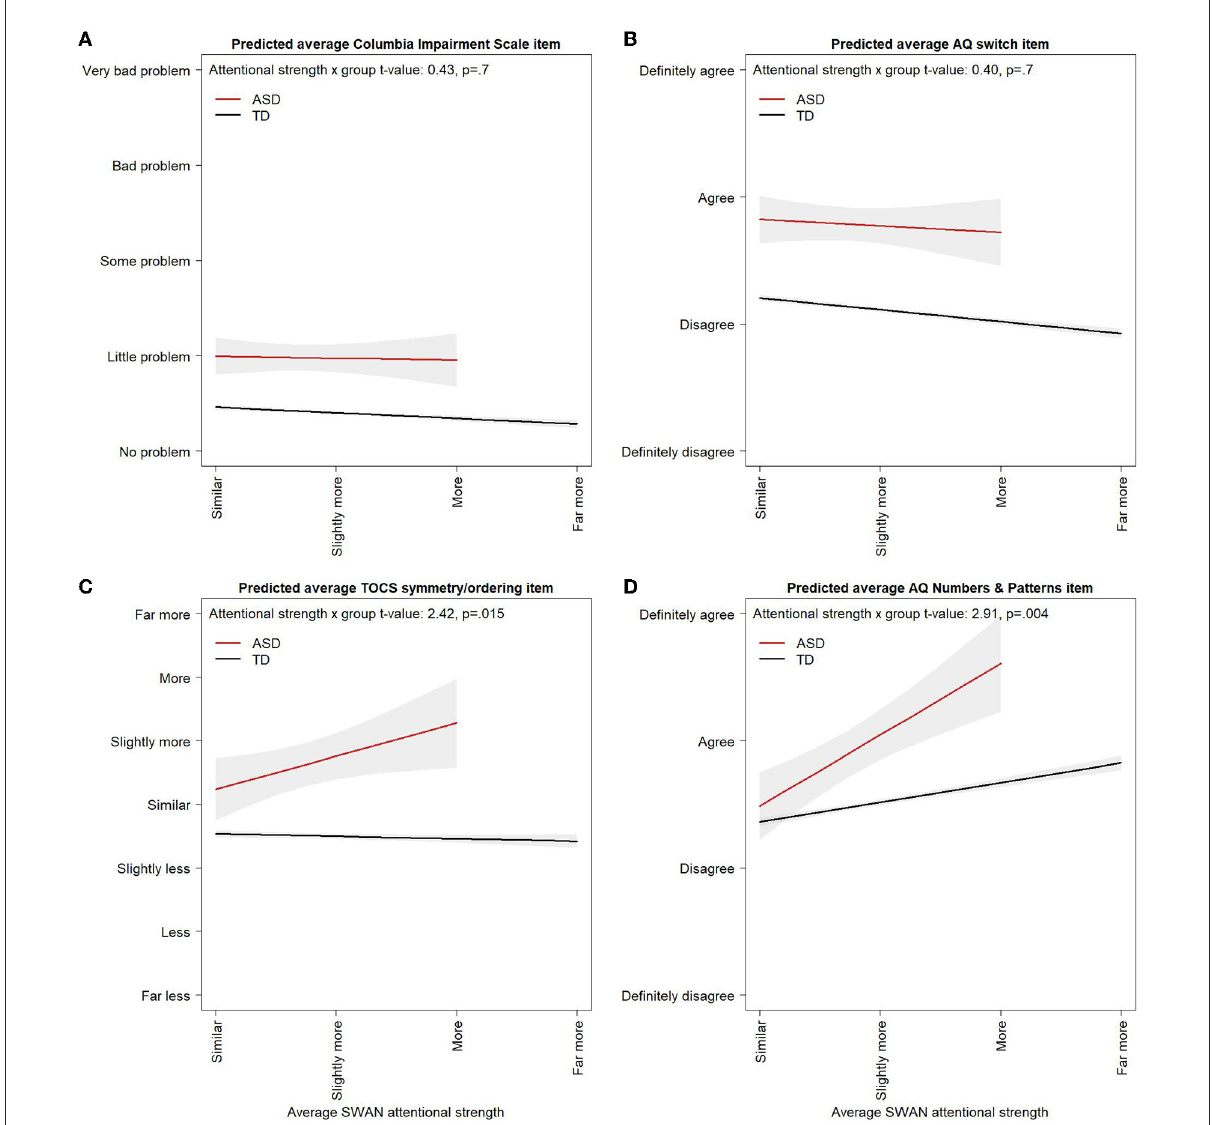
FIGURE3 Correlates of attentional strengths in ASD and controls. Multivariable linear regression model predicted values for (A) average AQ switching item, (B) average Columbia Impairment Scale item, (C) average TOCS symmetry/ordering item, and (D) average AQ-short-C Numbers and Patterns item across average attentional strength scores in the ASD and Control samples. Models control for age, gender, and attentional weakness scores. Multivariable linear regression model predicted values are shown for 11-year-old males with attentional weakness scores of 0. Varying the age or weakness score at which predicted values from the linear regression model are obtained would raise or lower the lines but would not alter the slopes or the difference between the ASD and Control groups. Predicted values for the ASD group are shown up to a maximum attentional strength score of 2 in orders to avoid extrapolating outside the observed range of the data. Some AQ-short-C items are reverse coded so that “definitely agree” always corresponds to the highest ASD trait level across all items. 95% Confidence Intervals are shown in light